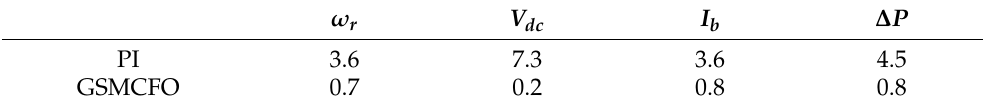
Table 4. Settling time comparison between the PI controller and the GSMCFO.